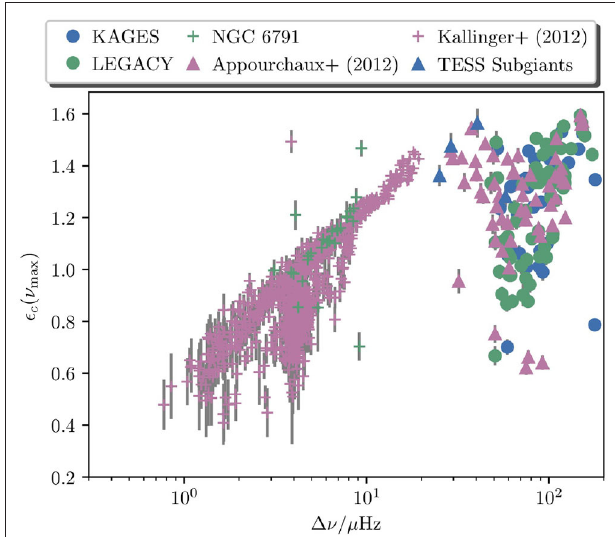
FIGURE 5 | The échelle diagram of the modes of KIC 6144777. As in Figure 4 , the black dots are radial modes, the red symbols are dipole modes FIGURE 7 | The asteroseismic phase function ǫ at ν max as a function of 1ν for with the m 0 indicated by filled triangles, while the m 1 and m 1 = = − = + stars observed with Kepler . The pink crosses are RGB and RC stars from modes are indicated with right and left pointing open triangles, respectively, Kallinger et al. (2012), with the red-clump stars forming a distinct group around the dipole modes with unidentified azimuthal orders are indicated with red a 1ν of 4 µ Hz. KAGES refers to the exoplanet-host sample of Davies et al. diamonds. The orange squares are quadrupole modes and the blue crosses (2016) and Silva Aguirre et al. (2015), and LEGACY to the sample of the octupole ( l 3) modes. Modes that could not be identified are indicated = main-sequence stars in Lund et al. (2017) and Silva Aguirre et al. (2017). by black asterisks. Note that the radial modes line up vertically, but not Appourchaux et al. (2012) has a mix of main-sequence and subgiant stars. perfectly, and there is a curvature (see text for more details). NGC 6791 refers to the sample analyzed by McKeever et al. (2019), and “TESS subgiants” are a set of sungiants in the TESS southern continuous viewing zone that show clear oscillations. Image courtesy of Joel